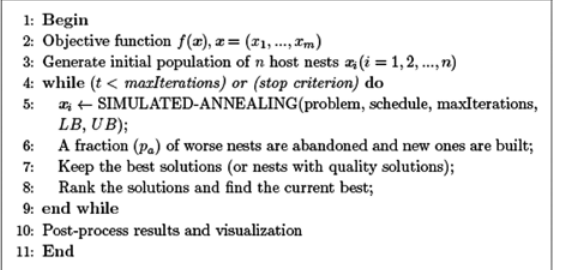
Figure 4: Hybrid CSA